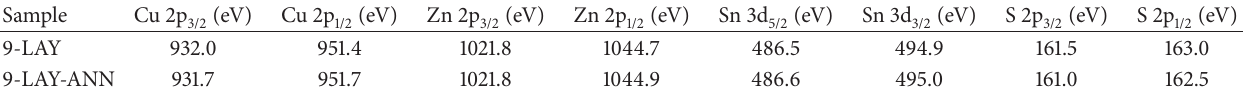
Table 2: Element binding energy values of CZTS films’ XPS spectra.